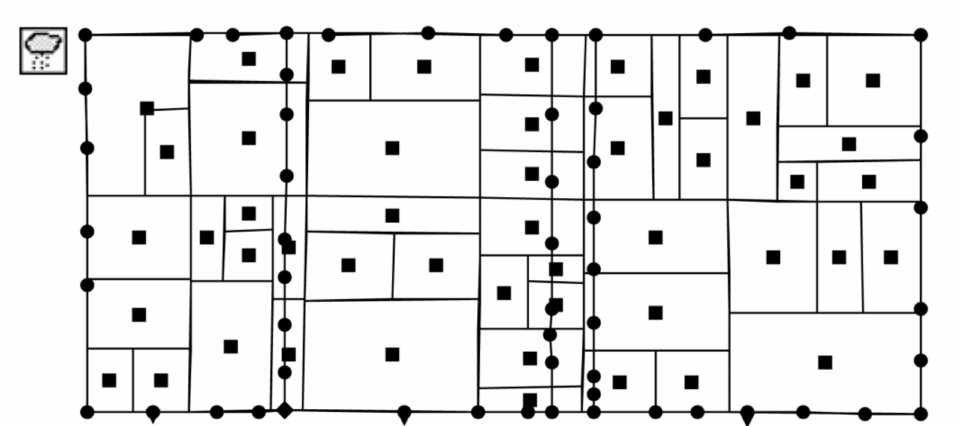
Figure 2. Generalization diagram of SWMM